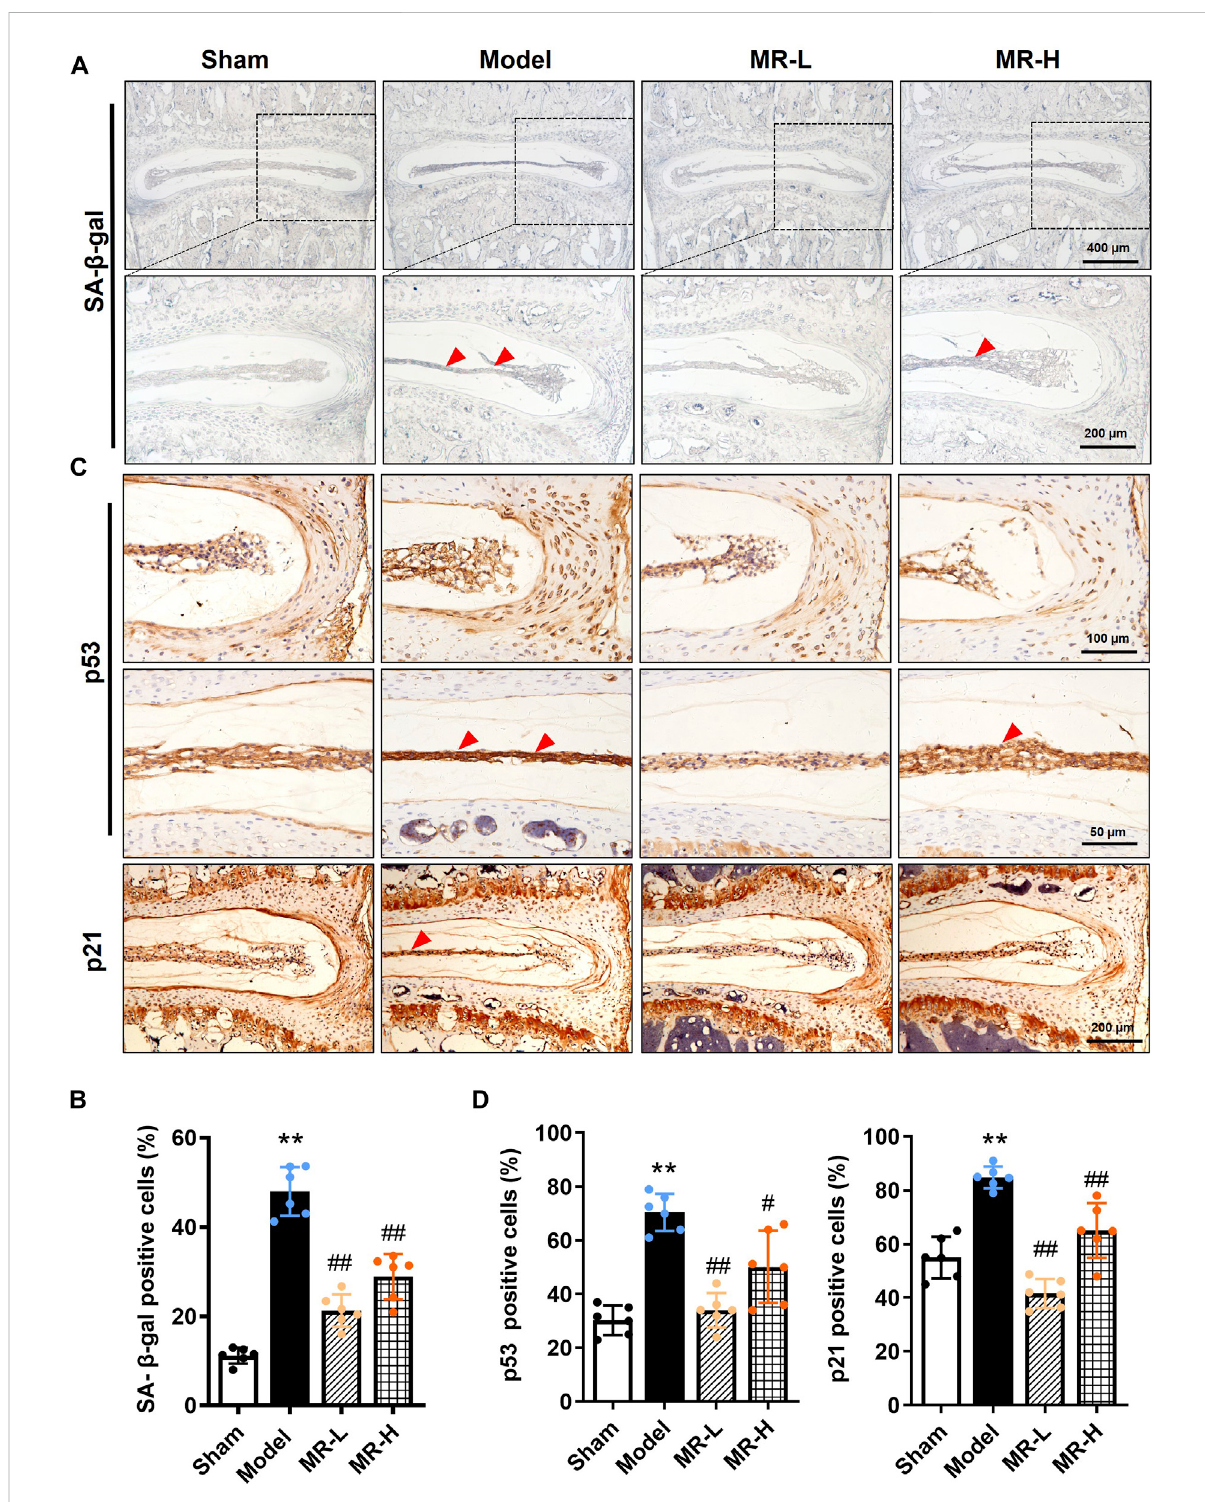
FIGURE 2 MR reverses the senescent phenotype of NP chondrocytes in IVDD mice. (A) The SA- β -gal staining results of IVDs of mice. Red arrowheads indicate positively-stained cells. (B) The ratio of SA- β -gal staining in (A) . (C) The IHC staining results of p53 and p21 in NP tissues of mice. Red arrowheads indicate positively-stained cells. (D) Quanti fi cation of p53-and p21-positive cells in NP tissues of mice in (C) . Data are expressed as the mean ± SD. ** p < 0.01 (vs. Sham group); # p < 0.05, ## p < 0.01 (vs. IVDD group), n = 10 per